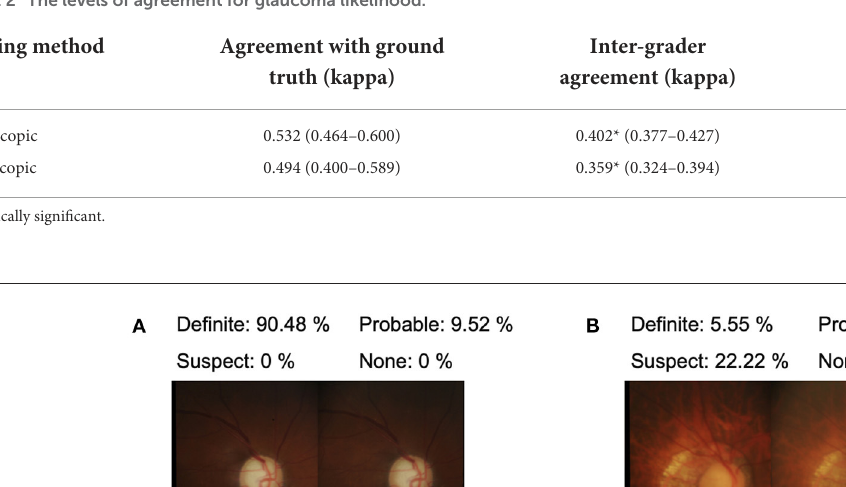
TABLE 2 The levels of agreement for glaucoma likelihood.